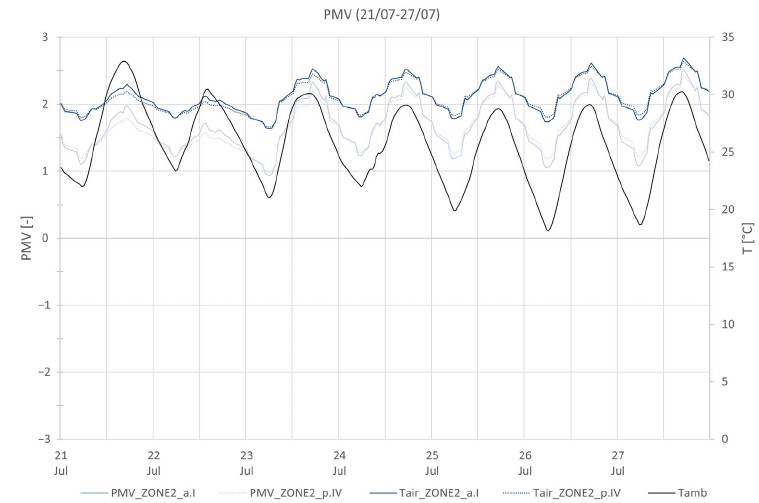
Figure 16. Comparison between PMV in current and low-e configuration during a typical summer week (floor 2).